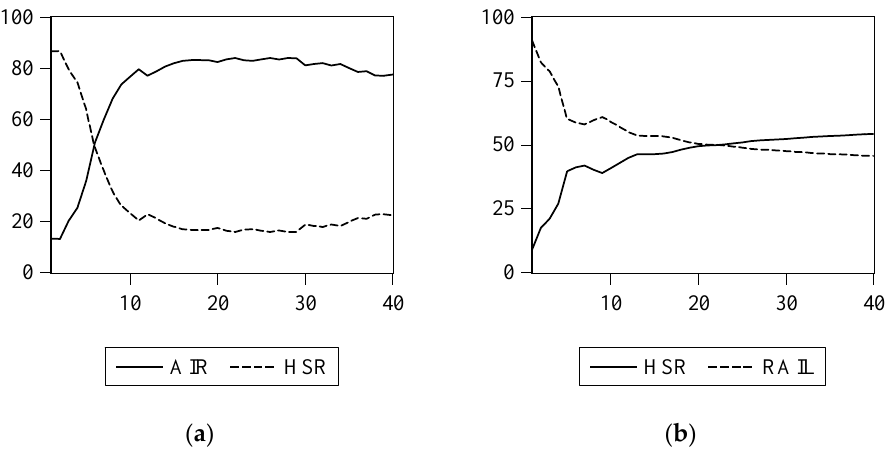
Figure 5. Variance decompositions for the three transport modes. ( a ) Variance Decomposition of HSR; ( b ) Variance Decomposition of RAIL.